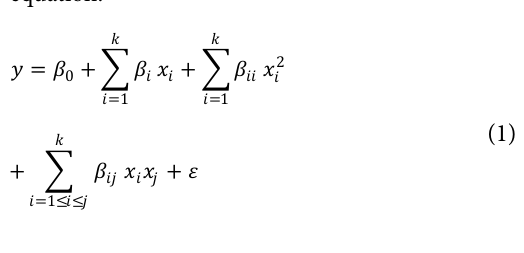
Fig. 1: MPA-capped CuInS 2 synthesis steps